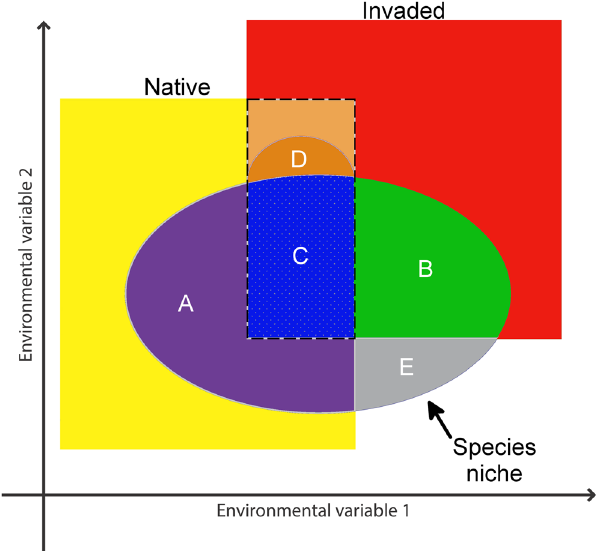
Figure 1. Framework of species’ ecological niches across accessible areas in native (yellow) and invaded (red) ranges. Portions of the niche are as follow: ( A ) native-range environments (purple): species using environments available only in the native range; ( B ) invaded environments (green): species using environments available only in the invaded range; ( C ) overlapping environments (dashed line): invaded-range populations using the same environments as in the native range (blue); ( D ) overlapping environments: species using novel environments in the invaded range (i.e., not used in the native range, even when available; dark orange); ( E ) Environments not available in either native or invaded ranges ( = the unfilled niche). Similar environments available in both, the native and invaded ranges are indicated with a dashed line. Arrow indicates the species’ fundamental niche ( A , B , C , D , E ). Figure done using GIMP2. GIMP Team, GIMP 2.8.10, www.gimp.org,